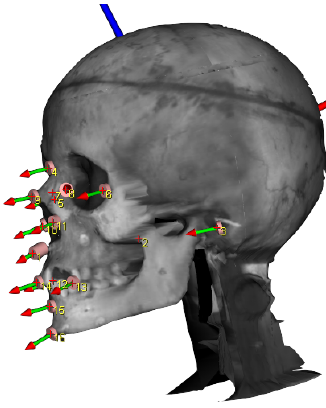
Figure 6. Soft tissue thickness accounting